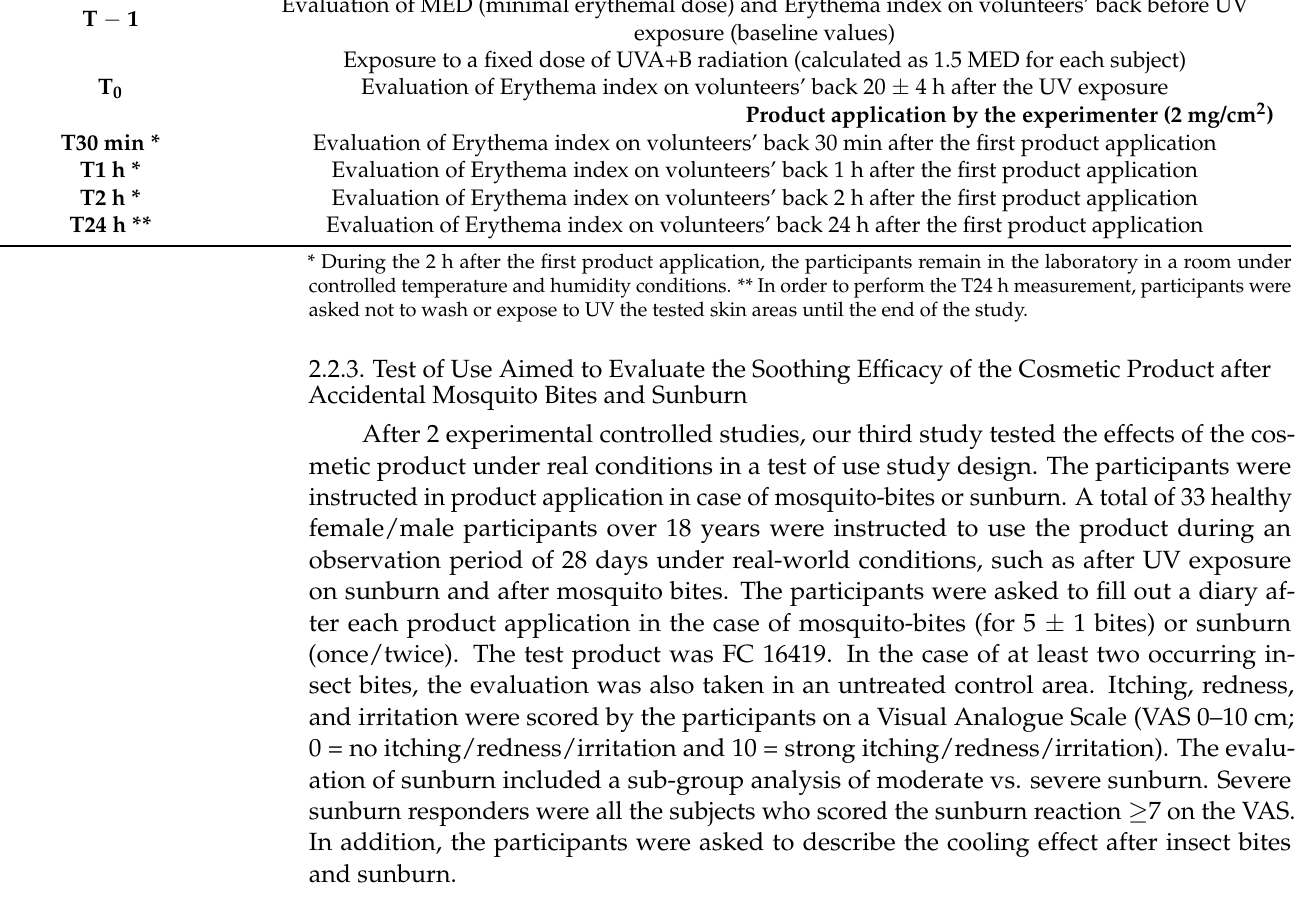
Table 2. Evaluation of product soothing effect after UV radiation. Area 1 Control Area—Untreated Area exposure (baseline